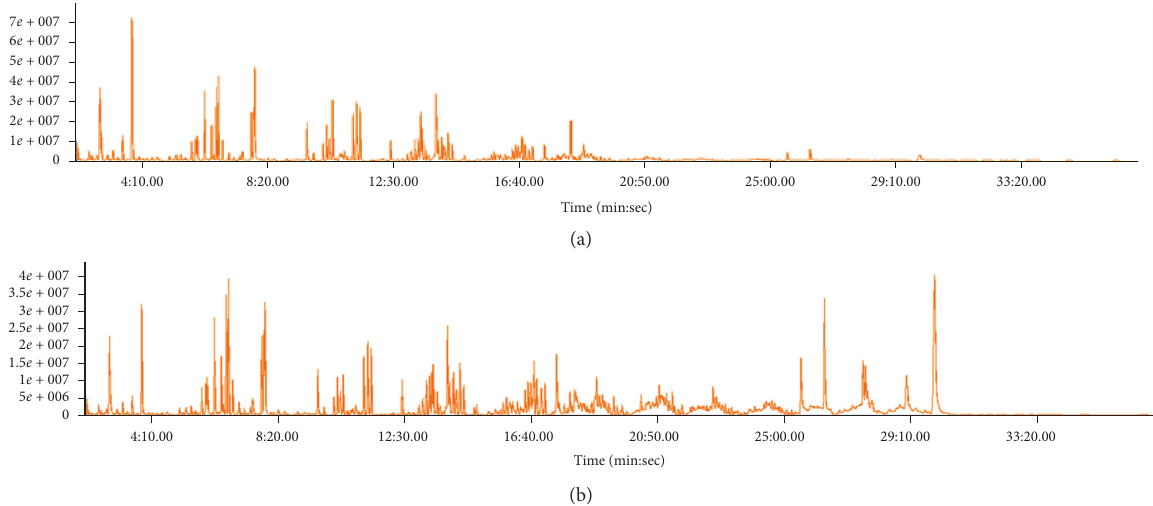
Figure 2: TIC (total ion chromatogram) of samples 17 (a) and 21 (b).